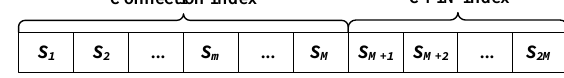
Figure 4. Encoding of particle i .